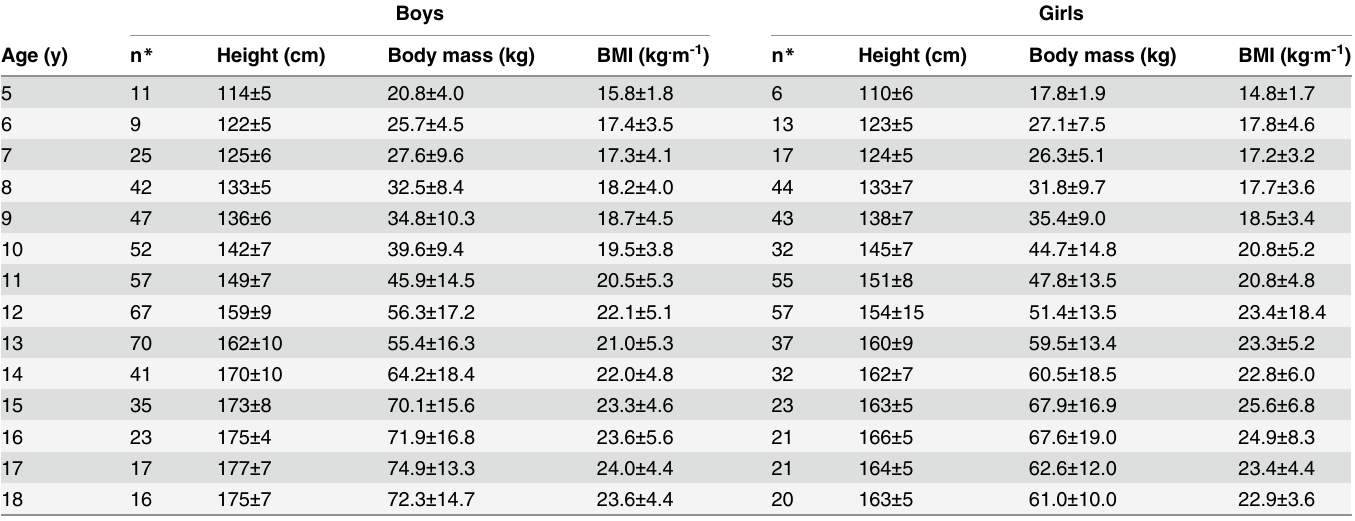
Table 2. Mean ± SD of physical characteristics of the boys (B) and girls (G) presented by